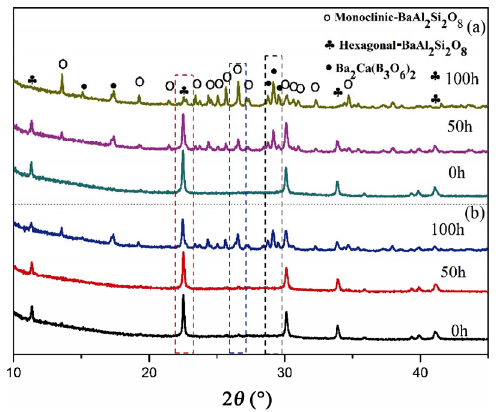
Fig. 6 XRD patterns of (a) A glass heat treated at 1023 K for 0, 50, and 100 h, and (b) B glass heat treated at 1023 K for 0, 50, and 100